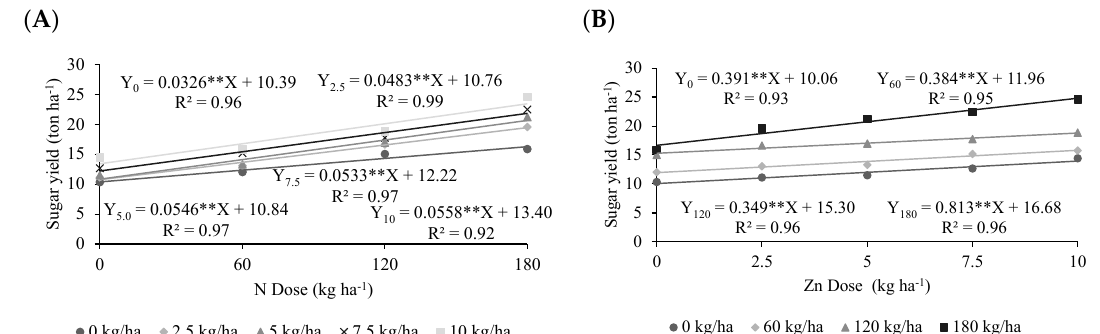
Figure 4. Sugar yield of sugarcane (plant crops) in response to nitrogen ( A ) and zinc ( B ) fertigation doses, under field conditions in Jataí, GO, Brazil. ** significant at p < 0,01 probability according to the F test. Doses of Zn, Y 0 : 0 kg ha − 1 of Zn, Y 2.5 : 2.5 kg ha − 1 of Zn, Y 5.0 : 5.0 kg ha − 1 of Zn, Y 7.5 : 7.5 kg ha − 1 of Zn and Y 10 : 10 kg ha − 1 of Zn ( A ). Doses of N, Y 0 : 0 kg ha − 1 of N, Y 60 : 60 kg ha − 1 of N, Y 120 : 120 kg ha − 1 of N, Y 180 : 180 kg ha − 1 of N ( B ).